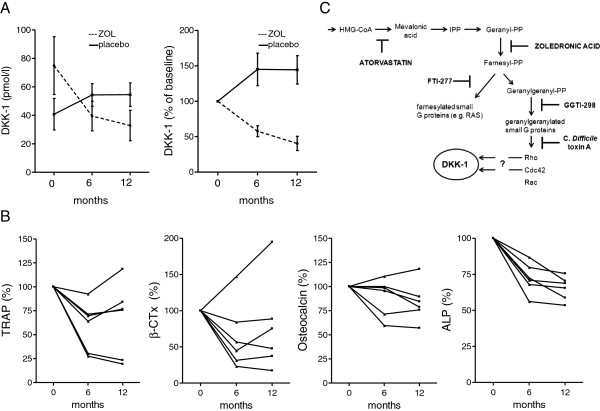
Dickkopf-1 levels are suppressed in women with breast cancer following zoledronic acid. (A) Dickkopf-1 (DKK-1) levels were measured in women with estrogen receptor (ER)-negative nonmetastatic breast cancer, who received 3-monthly infusions of zoledronic acid (ZOL; n = 6) or placebo (n = 3). DKK-1 levels are presented as mean absolute values and mean percentage of baseline expression. (B) Markers of bone turnover were assessed at the same time points as DKK-1. Values are presented as percentage of baseline expression. (C) Schematic regulation of DKK-1 by mevalonate pathway modulators via inhibition of Cdc42 and Rho. ALP, alkaline phosphatase; CTx, C-terminal telopeptide; IPP, isopentenyl pyrophosphate; TRAP, tartrate-resistant acid phosphatase; PP, pyrophosphate.